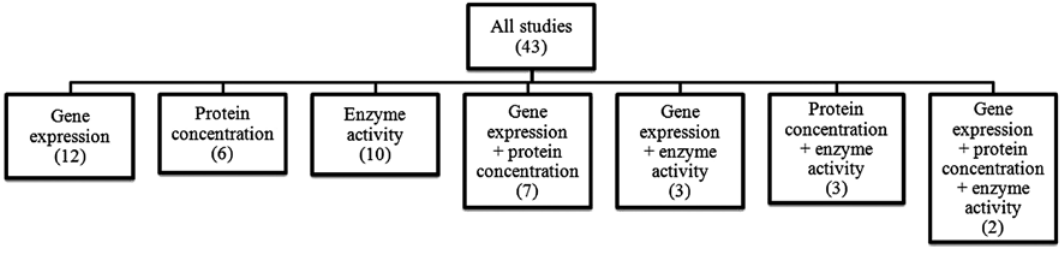
Figure 2: Distribution of cited articles according to methodology used to evaluate NPs effects on